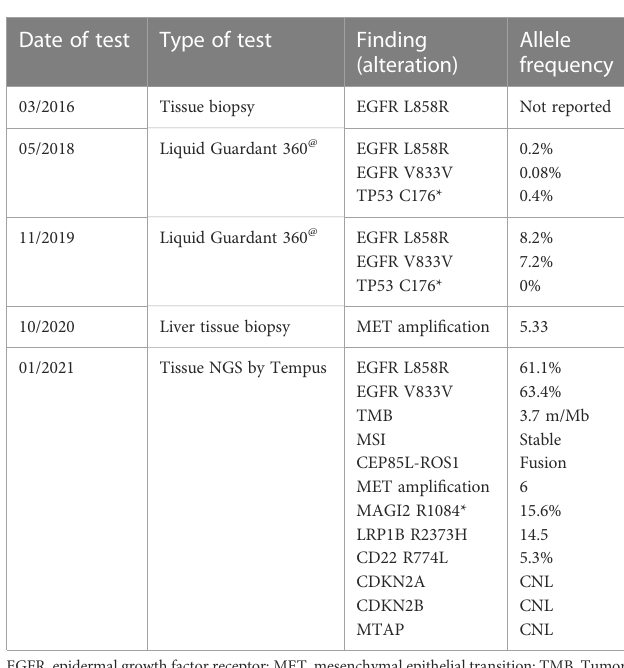
TABLE 1 Somatic genes alteration detected throughout the treatment of the 1st